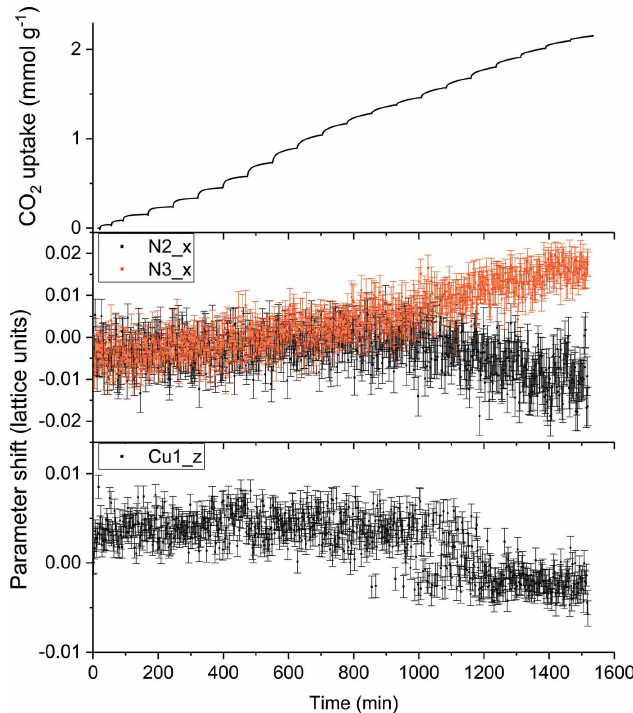
Figure 3 (Left) Schematic of gas exchange in a hydrate, proceeding through transport of CO 2 from the particle surface to the core and the opposite migration of CH 4 . (Right) CH 4 cage occupancies in large and small cages (LC and SC, respectively) as a function of CO 2 content. Reprinted and adapted with permission from Falenty et al. (2016). Copyright (2016) American Chemical Society.